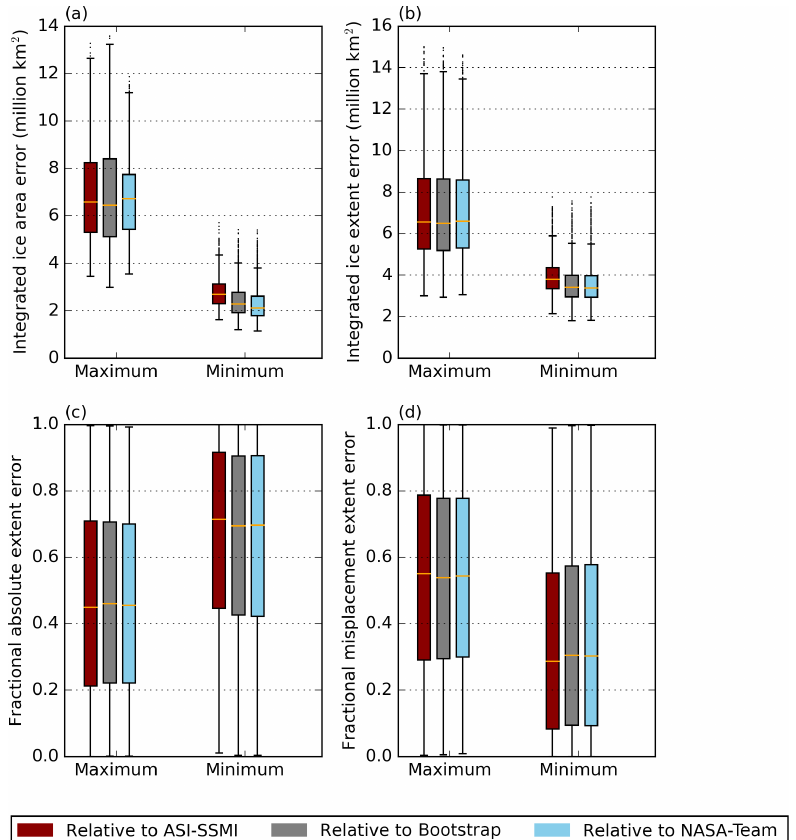
Figure 2. Various ice errors for the population of CMIP5 models for all years from 1992 to 2014. Errors are shown relative to (red) the ASI-SSMI satellite observations, (grey) the Bootstrap satellite observations, and (light blue) the NASA Team observations for the months where the maximum and minimum of the seasonal cycle occur of sea ice area (a) or of sea ice extent (b, d) occur. The errors shown are the integrated ice area error (a) , the integrated ice extent error (b) , the absolute extent error divided by the integrated extent error (c) , and the misplacement extent error divided by the integrated extent error (d) . Box plots are as in Fig.